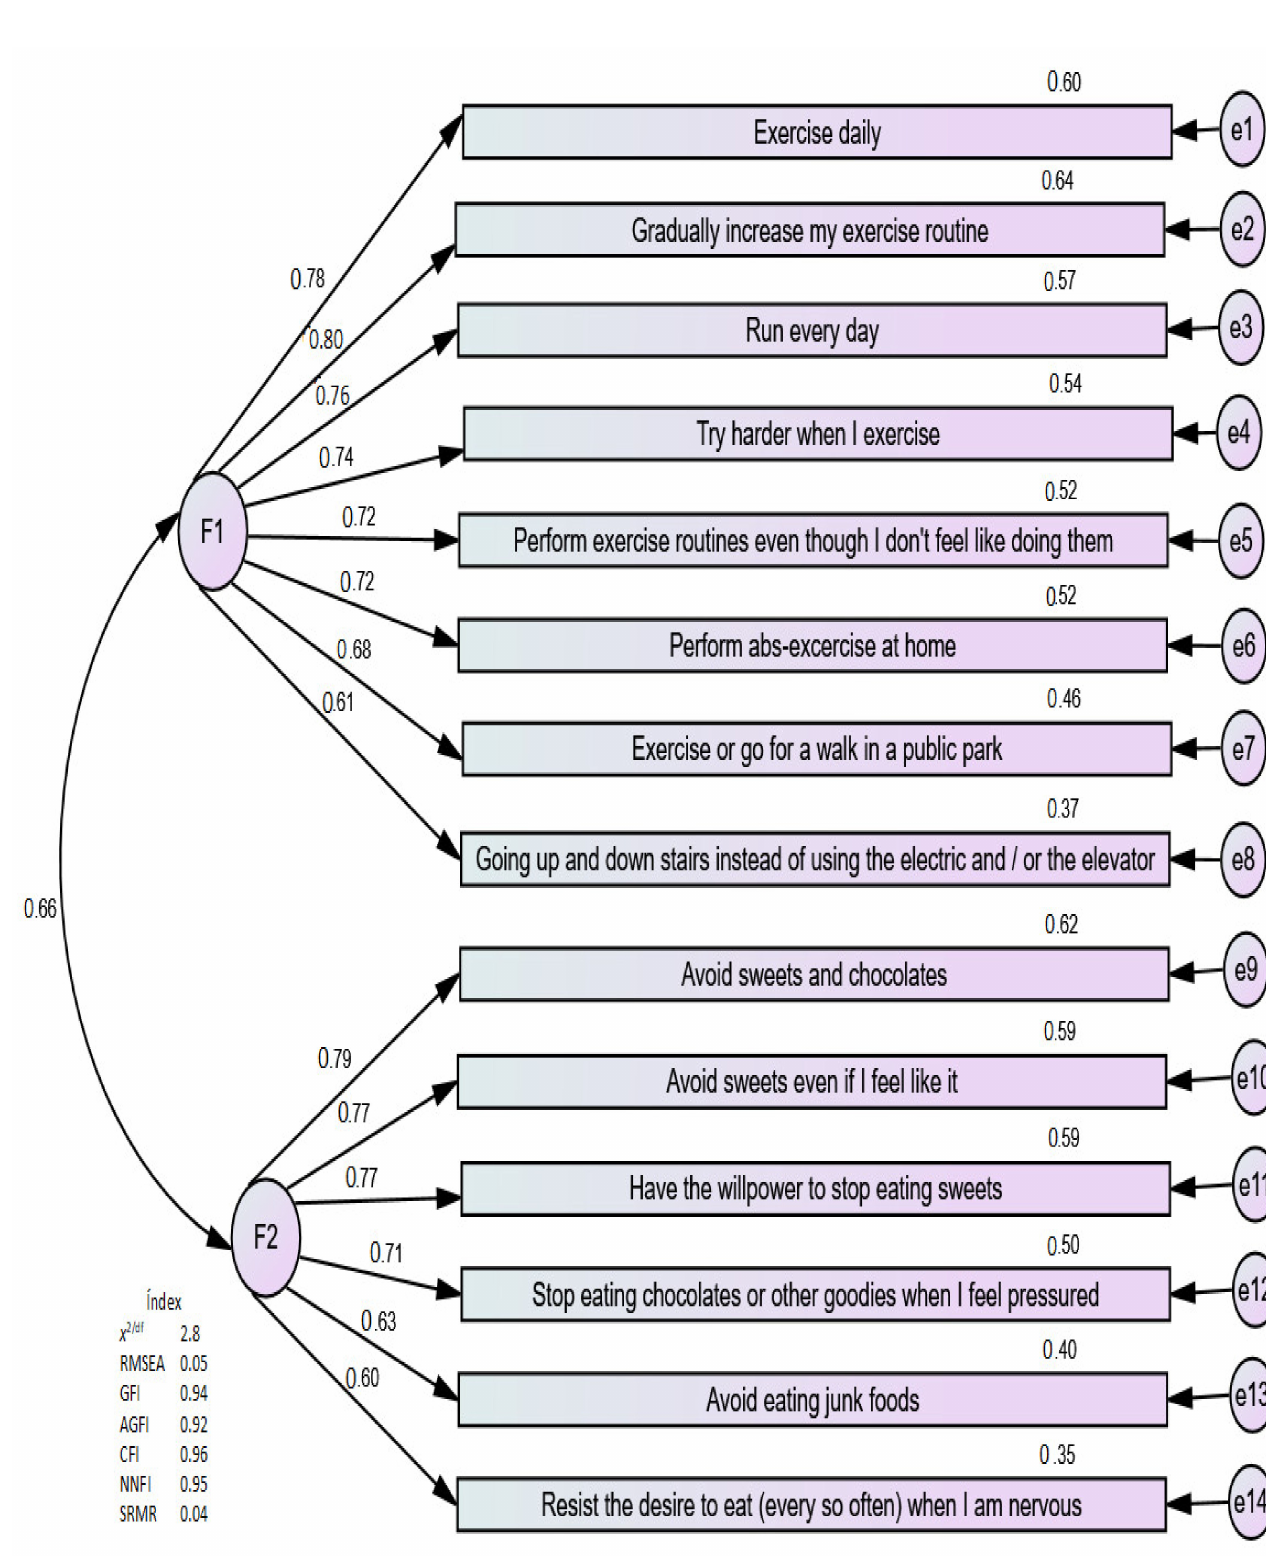
Figure A2. Confirmatory girls